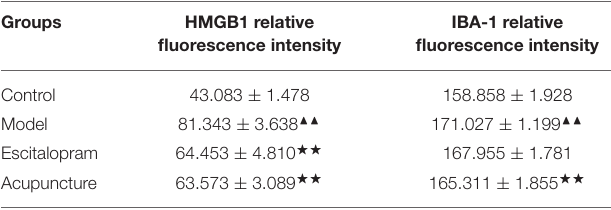
TABLE 3 | Effects of acupuncture on the expression of HMGB1 and IBA-1 in the hippocampus of CRS rats.